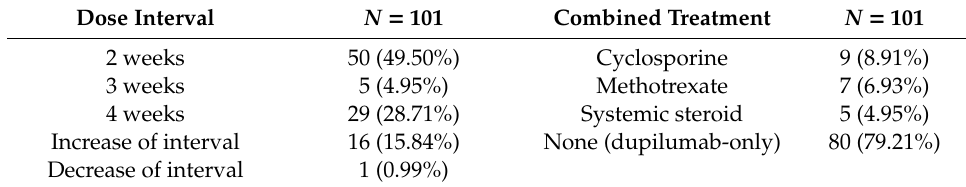
Table 2. Characteristics of treatment.